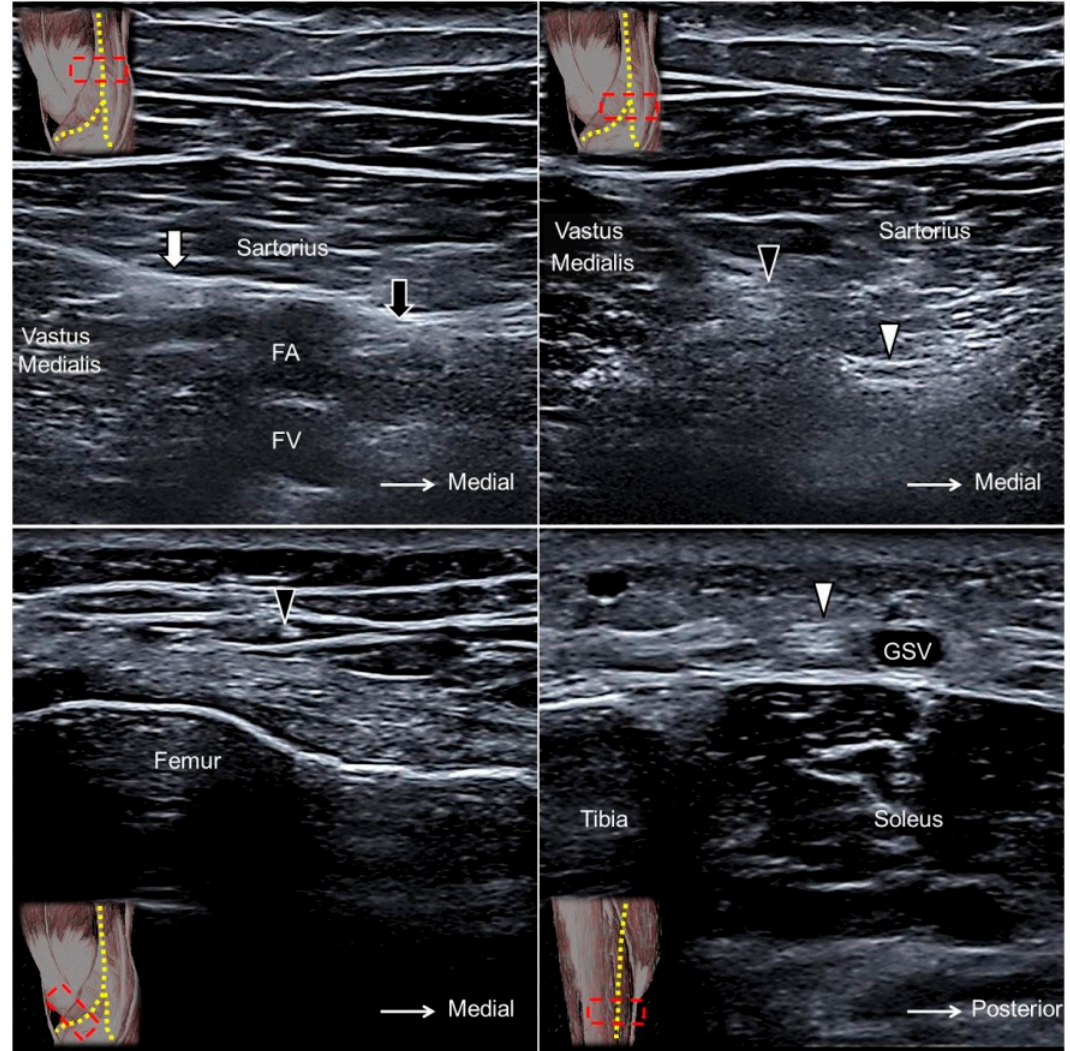
Figure 13. The saphenous nerve (black arrow) proximal to the exit of the adductor canal (A) . The infrapatellar (black arrowhead) and sartorial (white arrowhead) branches of the saphenous nerve at the exit of the adductor canal (B) . The infrapatellar branch on the distal femur (C) and the sartorial branch on the distal tibia (D) . White arrow, nerve to the vastus medialis muscle; FA, femoral artery; FV, femoral vein; GSV, great saphenous vein.